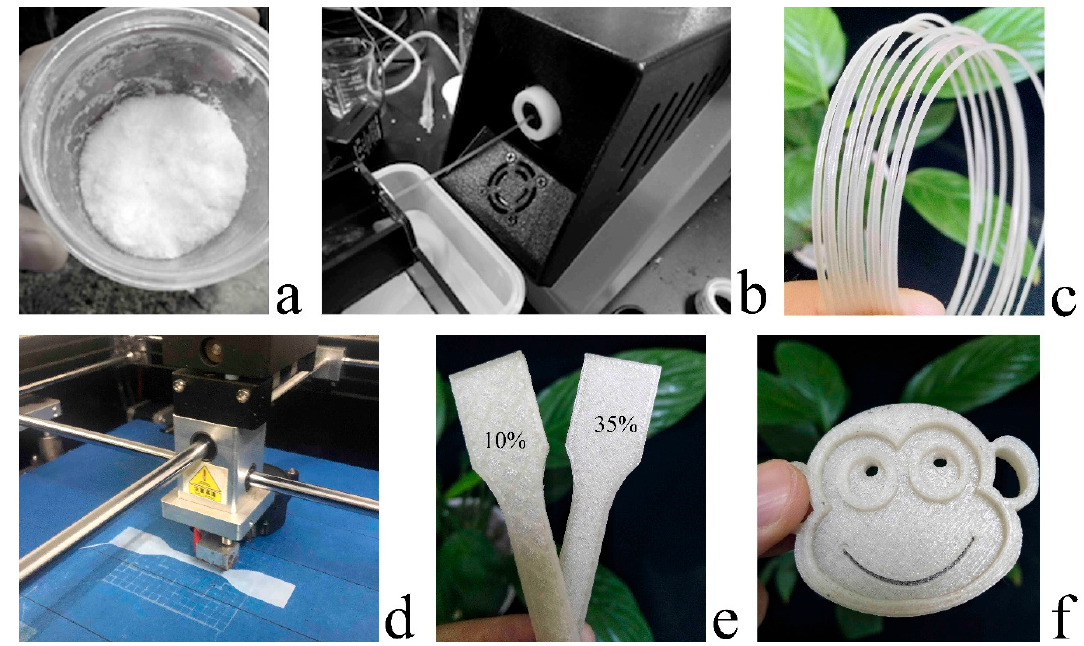
Figure 1. Cellulose nanofibrils (CNF) powder: ( a ) composite filament extruded on Wellzoom desktop extruder; ( b ) composite filament (1.75 mm diameter); ( c ) specimen in printing on M3036 FDM desktop 3D printer; ( d ) 3D-printed specimen with 10% and 35% infill; ( e ) 3D-printed specimen monkey face with 40 mm/s printing speed and 100% infill ( f) .